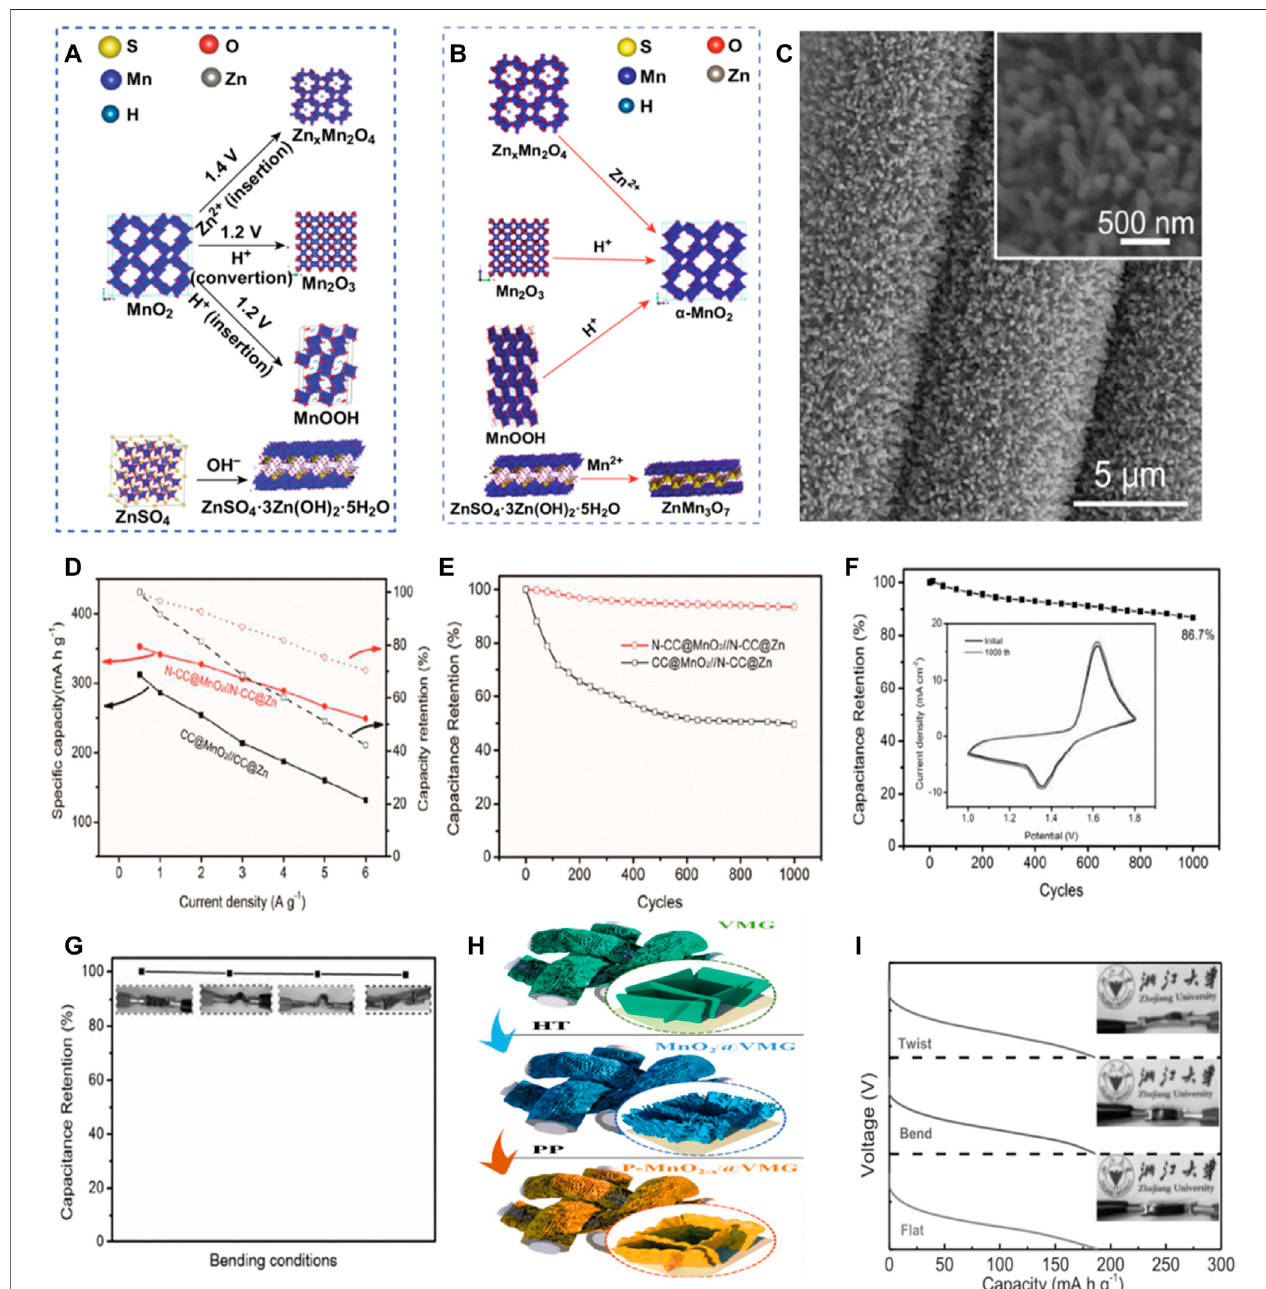
FIGURE 2 | Phase evolution of cathode during the fi rst discharge process (A) and charge process (B) . Copyright 2019 Springer. (C) SEM images of the N-CC@ MnO 2 ;insetisthecorrespondingmagnifedSEMimage. (D) N-CC@MnO 2 //N-CC@ZnandCC@MnO 2 //N-CC@Znthespeci fi ccapacityandcapacityretentionrateofthe batteryasafunctionofcurrentdensity (E) CyclingperformanceoftheN-CC@MnO 2 //N-CC@ZnandCC@MnO 2 //N-CC@Znbatteriescollectedat1A/gfor1,000cycles. (F) Capacityretentionrateofthebatteryafter1,000cyclesatthecurrentdensityof1A/gN-CC@MnO 2 //N-CC@Zn.TheCVcurvesofthe fi rstand1000 th cyclesare illustrated. (G) At different bending conditions N-CC@MnO 2 //N-CC@Zn battery capacity retention rate.Copyright 2017 Journal of Materials Chemistry A. (H) For